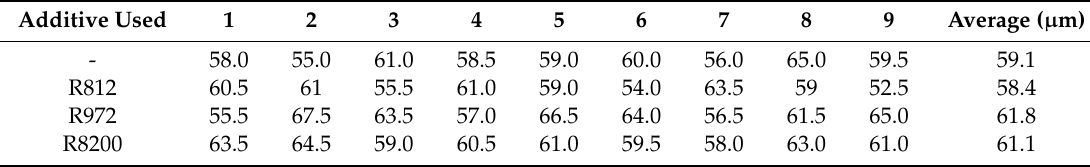
Table 5. Thickness Reading–Polyester Powder Experimental Results.